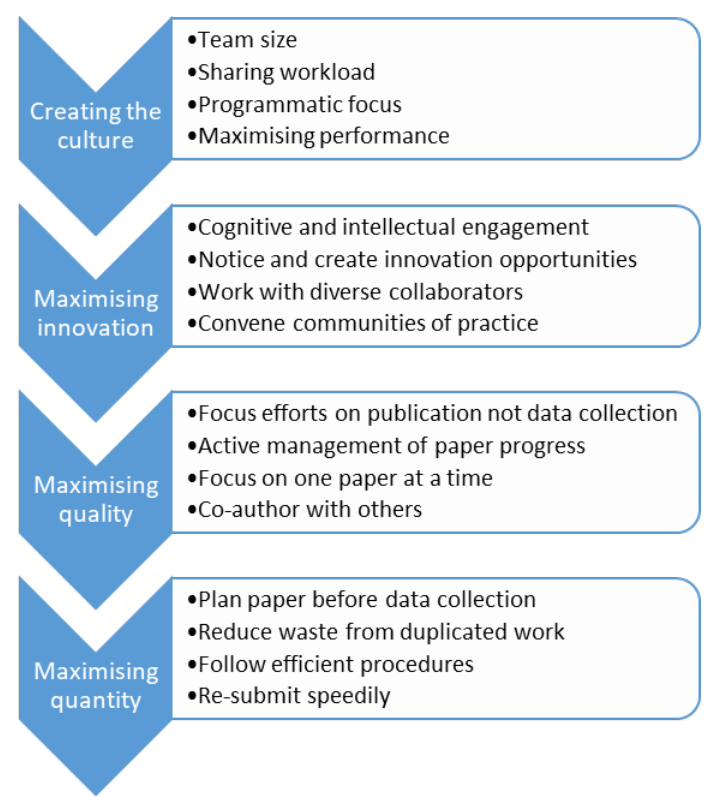
Figure 1. Recovery Research Team approach.